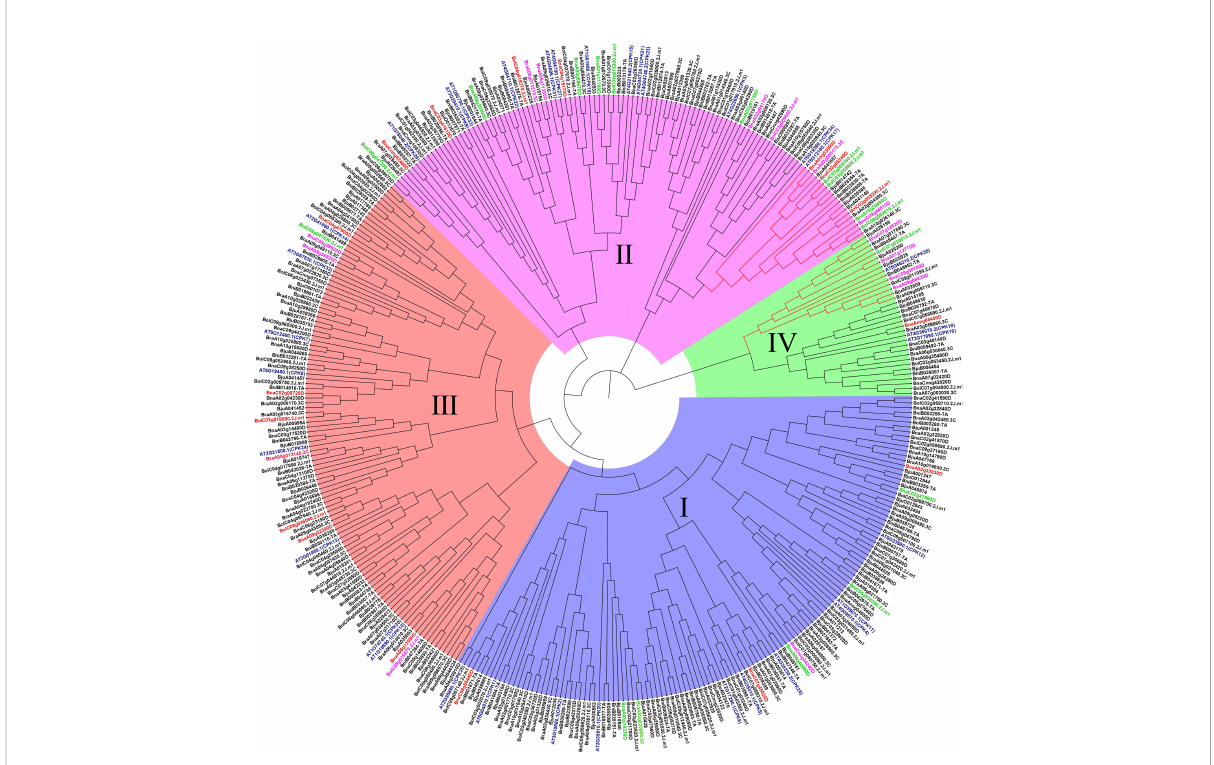
FIGURE 7 Phylogenetic tree of CPK proteins of A. thaliana and fi ve Brassica species. The phylogenetic tree was generated by the NJ method with bootstrap analysis (2,000 bootstrap replicates) by the MEGA 11.0. The CPK proteins were clustered into four groups (group I, group I, group III, and group IV). Blue mark AthCPK genes, red mark upregulated-CPKs in resistance (R) genotype only, green mark upregulated-CPKs in susceptible (S) genotype only, pink mark upregulated-CPKs both resistance (R) and susceptible (S) genotypes. Red lines mark At5G12180.1 (CPK17) and AT5G66210.3 (CPK28)